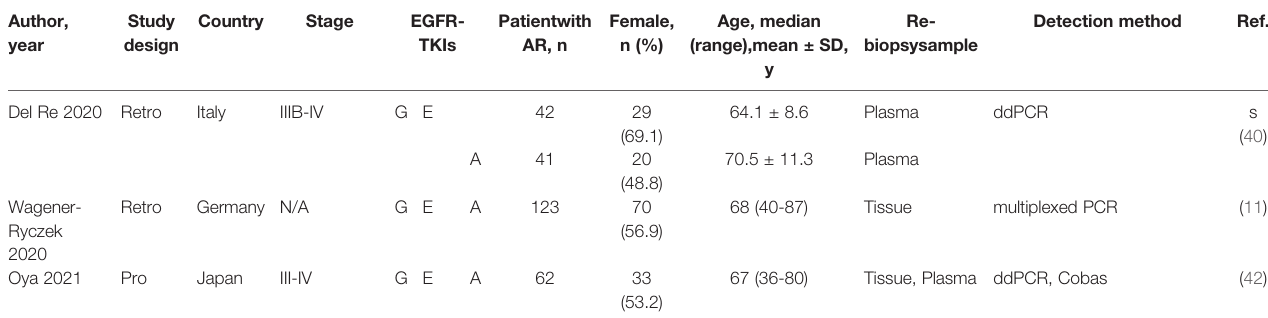
network meta-analysis. The structure of the network is shown in Figure 2A . A forest plot of the network meta-analysis is shown in Figure 2B . There was no statistical heterogeneity among the included studies, with an I 2 of 0% (95% CI: 0 – 32.6), and the Q statistic was 25.04% ( p = 0.57) for within-design and 1.56 ( p = 0.66) for between-designs, indicating no heterogeneity and consistency in the model used. Compared with afatinib, a higher OR of acquired T790M acquisition rate was observed after erlotinib (OR = 1.48; 95% CI: 1.09 – 2.00) and ge fi tinib (OR = 1.45; 95% CI: 1.11 – 1.90) treatments. The results also indicated with icotinib (OR = 0.91, 95% CI: 0.46 – 1.79) compared with